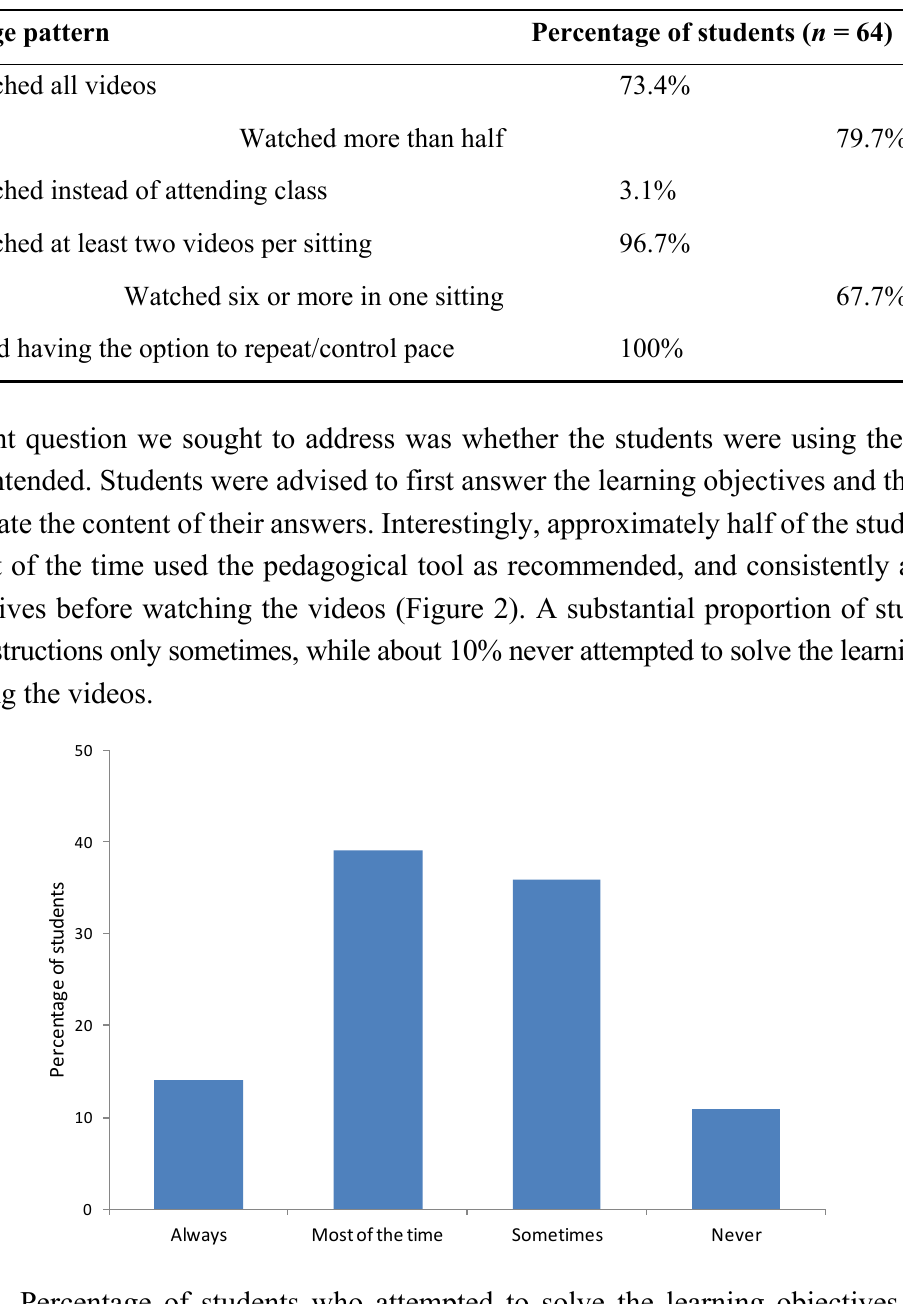
Figure 2. Percentage of students who attempted to solve the learning objectives before accessing the